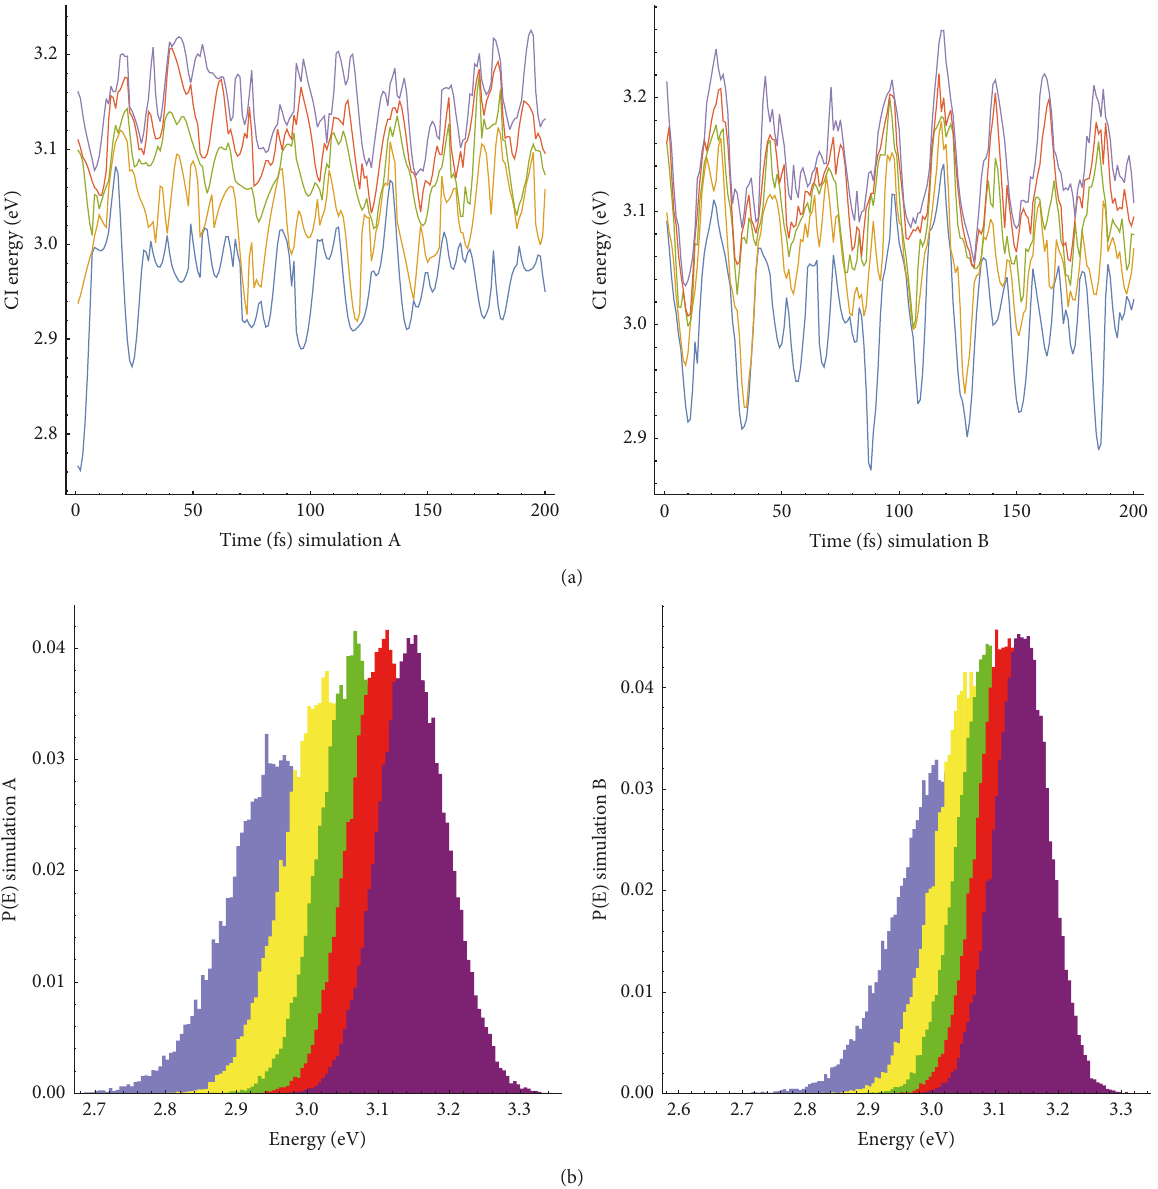
Figure 4: (a) Excitation energies for simulations A and B for the first 200 fs following excitation to the lowest SCI state. Each colored line corresponds to the excitation energy from the ground electronic state to one of the lowest 5 singlet excited states. (b) Histogram distributions of the 5 lowest excitation energy levels over a 200 ps simulation. Throughout the simulation, colors of each histogram correspond to the time-histories plotted in